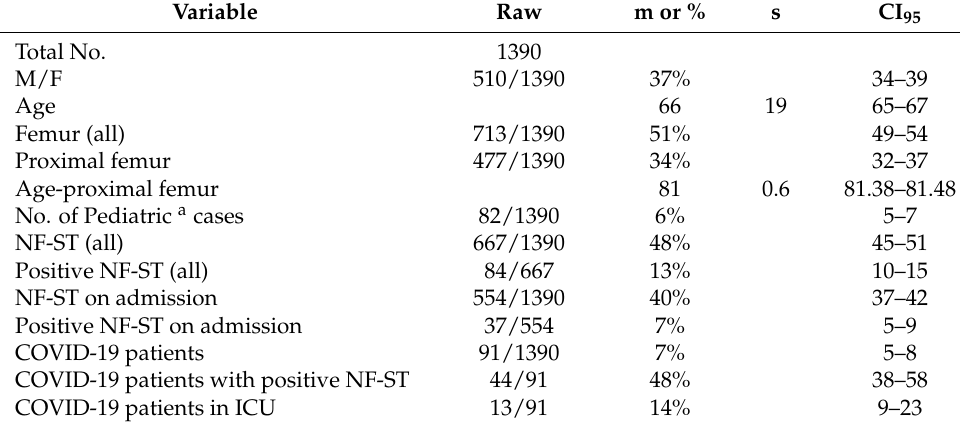
Table 2. Patients’ demographic